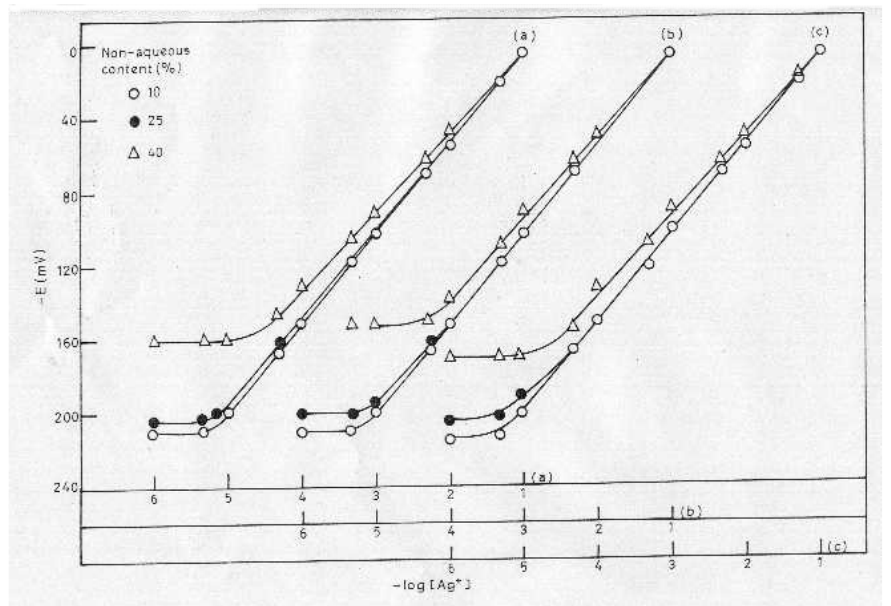
Figure 3. Variation of cell potential with Ag + concentration in (a) ethanol-water (b) methanol-water and (c) acetone-water